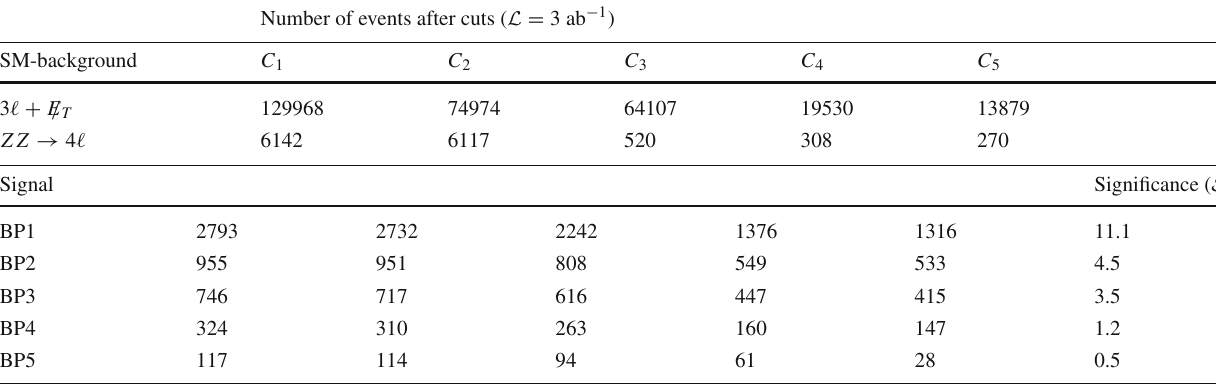
Table 14 The cut-flow for signal and backgrounds along with the significance for BP1, BP2, BP3, BP4 and BP5 at 14 TeV LHC for 3 ab − 1 integrated luminosity for the pp → 3 (cid:3) + E T / channel Number of events after cuts ( L = 3 ab − 1 )